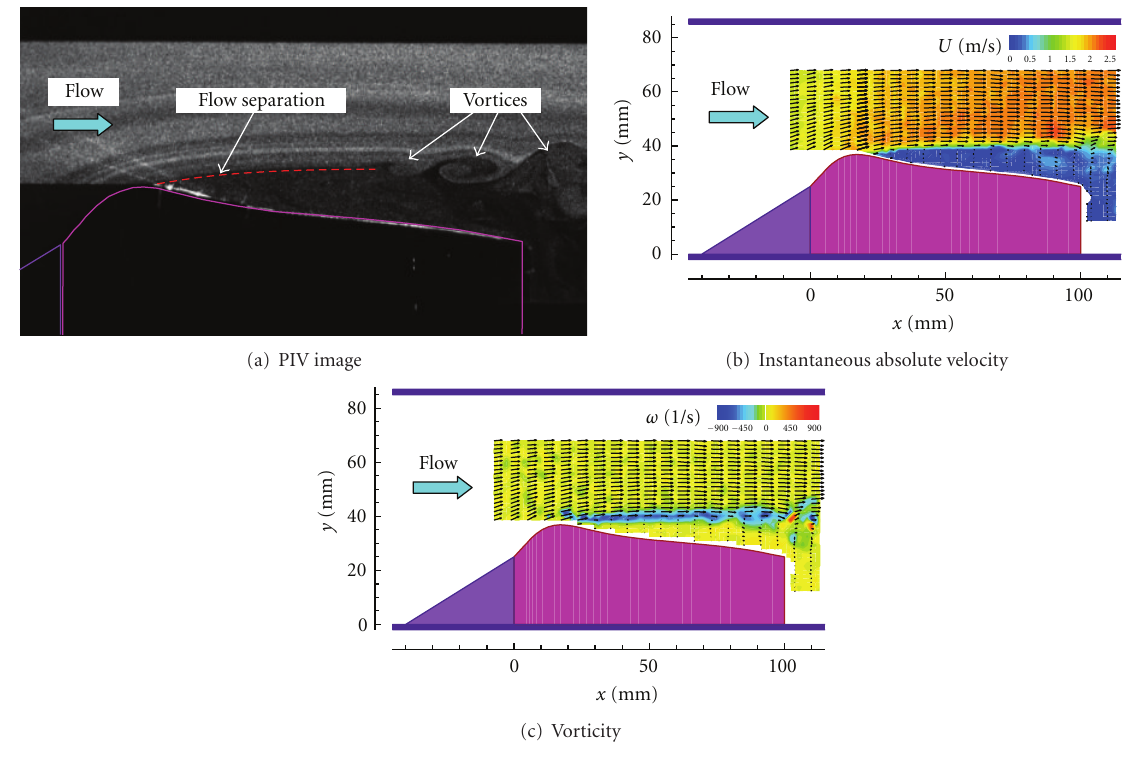
Figure 5: PIV measurements (baseline, plasma actuator o ff ).